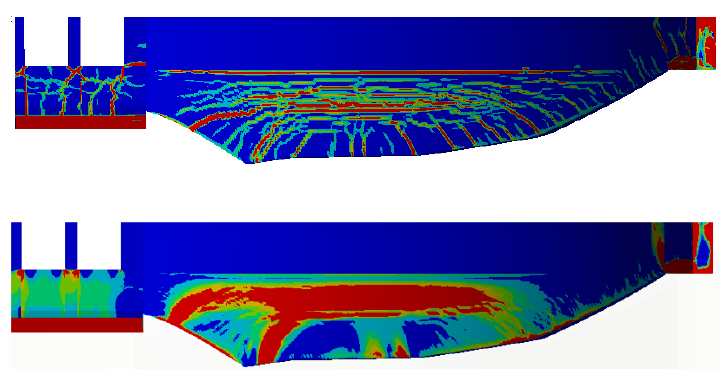
Figure 10. Example of an illustration of the predicted extent of cracking from contributor No. 5 using a lower fracture energy (200 Nm/m 2 in the top) and a higher fracture energy (500 Nm/m 2 bottom).